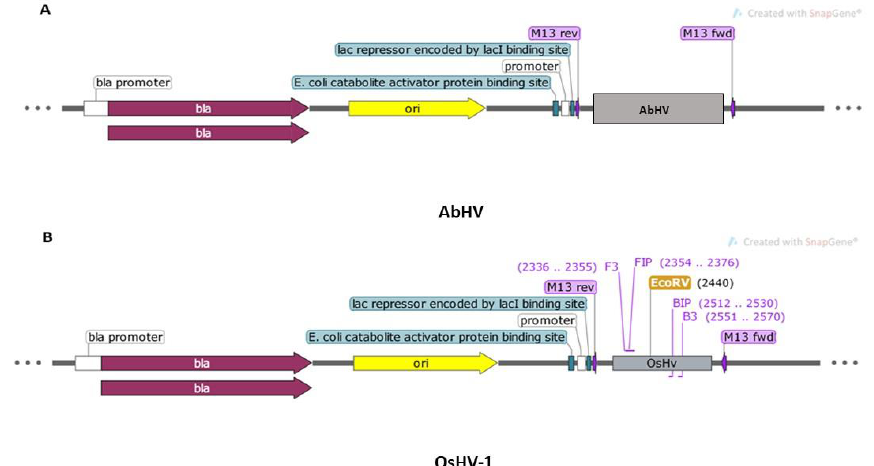
Figure 2. Maps showing the composition of two synthesized plasmids and primers binding to the target visualized using SnapGene 5.0.3.: ( A ) AbHV (3263 bp) and ( B ) OsHV-1 (3127 bp).